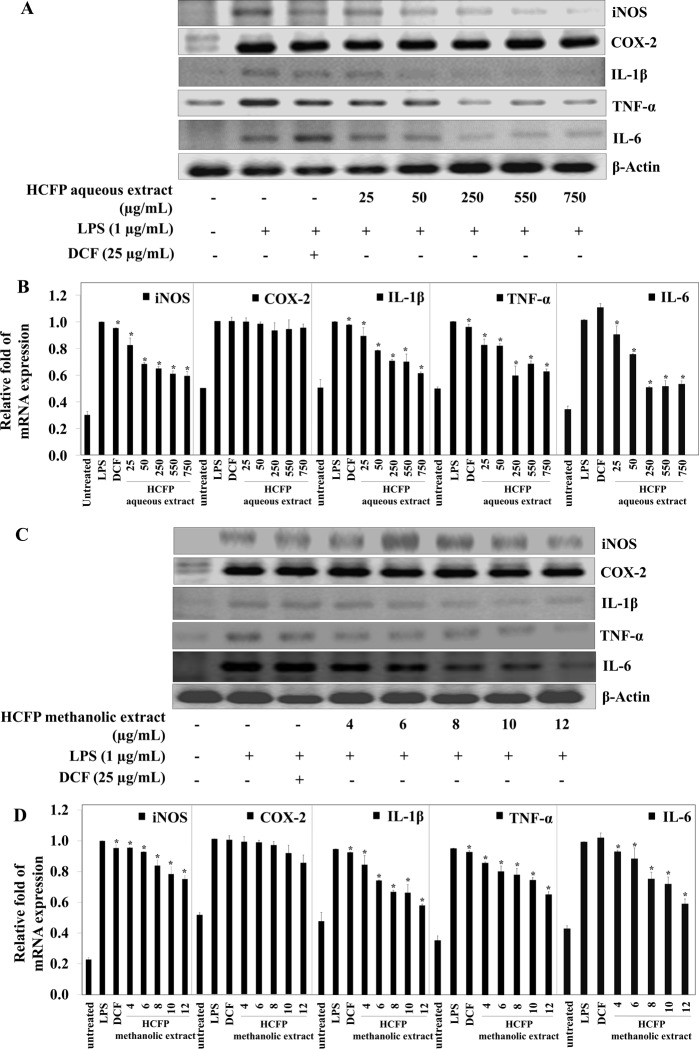
Effect of aqueous and methanolic extracts of HCFP on mRNA expression of iNOS, COX-2, IL-1β, TNF-α, and IL-6 in LPS-stimulated RAW264.7 cells.The cells were pre-treated with indicated concentrations of aqueous and methanolic extracts for 2 h and then stimulated with LPS (1 μg/mL) for 6 h. The mRNA expression levels of aqueous extract-treated (A) and methanolic extract-treated (C) cells were determined by reverse transcription-PCR. Bar graphs showed the relative fold of mRNA expression of aqueous extract-treated (B) and methanolic extract-treated (D) cells, *p < 0.05 compared with the LPS group.